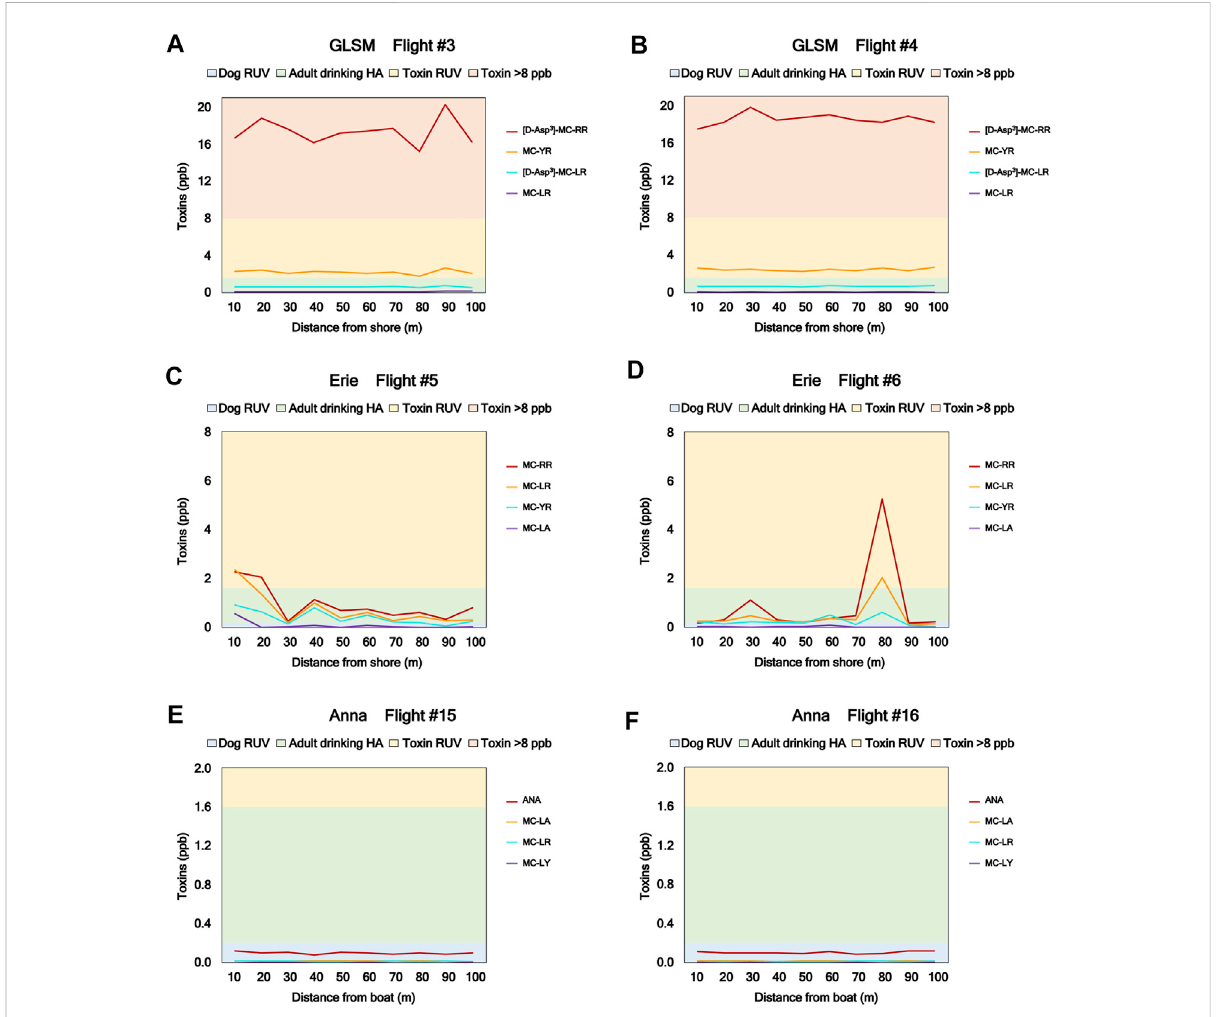
FIGURE 4 Graphicalsummaryoftoxinsfromtwo fl ightscollectedfromeachlake.ThedatashownforGLSM (A,B) ,LakeErie (C,D) ,andLakeAnna (E,F) were collected in consecutive fl ights. Distance across the 100 m transect is shown on the x-axis. Toxin concentration in ppb is shown on the y-axis. The color bands denote water quality conditions relative to toxin load. Water quality metrics for MC toxin concentrations are shown in Table 1 and correspondtothetrophicstatelakeclassi fi